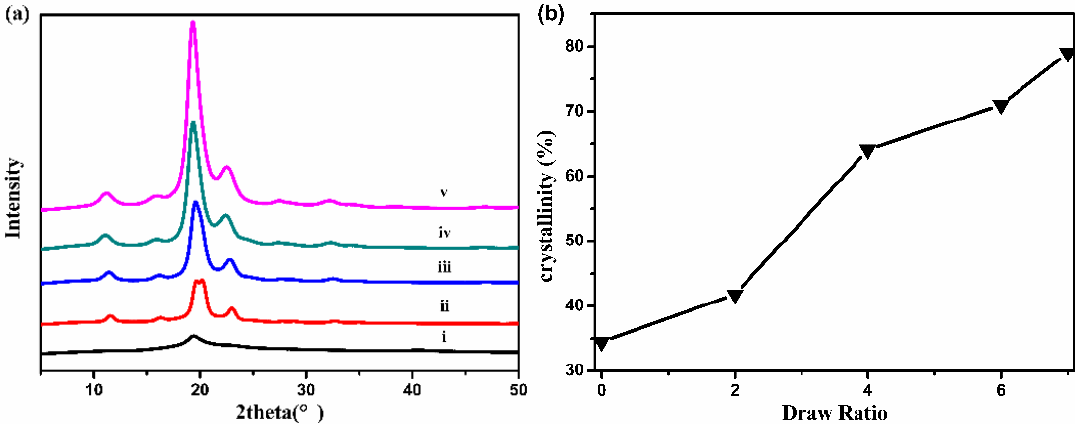
Figure 6. X-ray diffraction curves ( a ) of triangular PVA fibers with different draw ratios: (i) 0; (ii) 2; (iii) 4; (iv) 6; (v) 7 and the crystallinity ( b ) of triangular PVA fibers at different draw ratios.